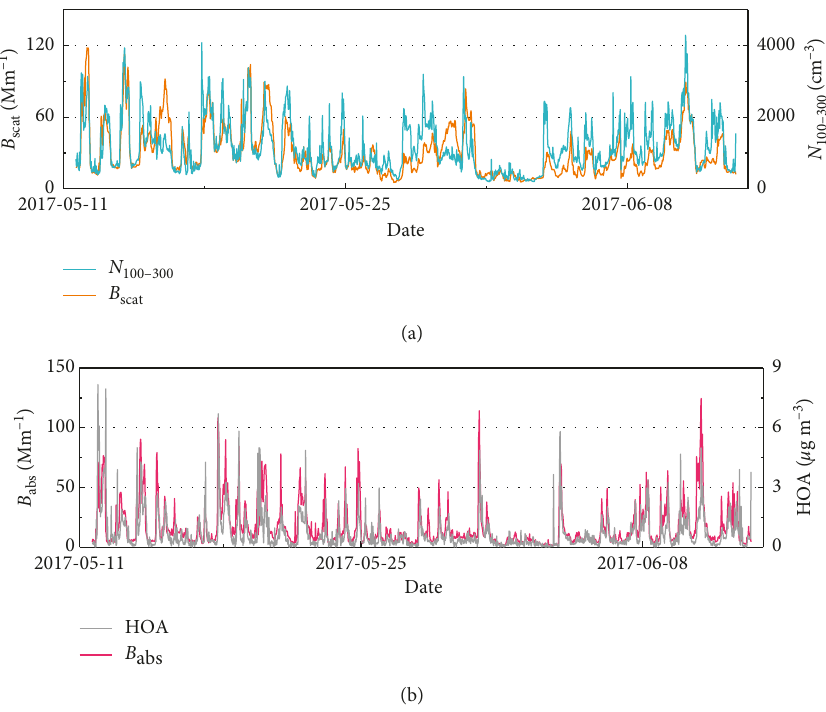
Figure 3: Temporal variations in (a) B scat (yellow) and N 100–300 (blue) and (b) B abs (pink) and HOA